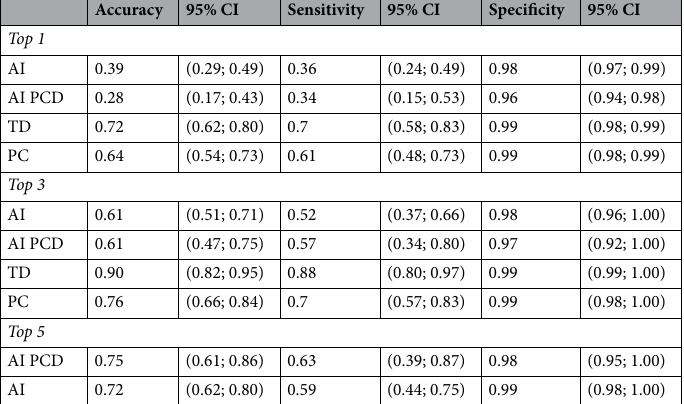
Table 3. Overall diagnostic accuracy of artificial intelligence, teledermatology and primary care. Mean sensitivity and specificity for each of the diagnoses. AI Artificial intelligence, AI PCD Artificial intelligence polarised light contact dermoscopy, TD Teledermatology, PC Primary care.